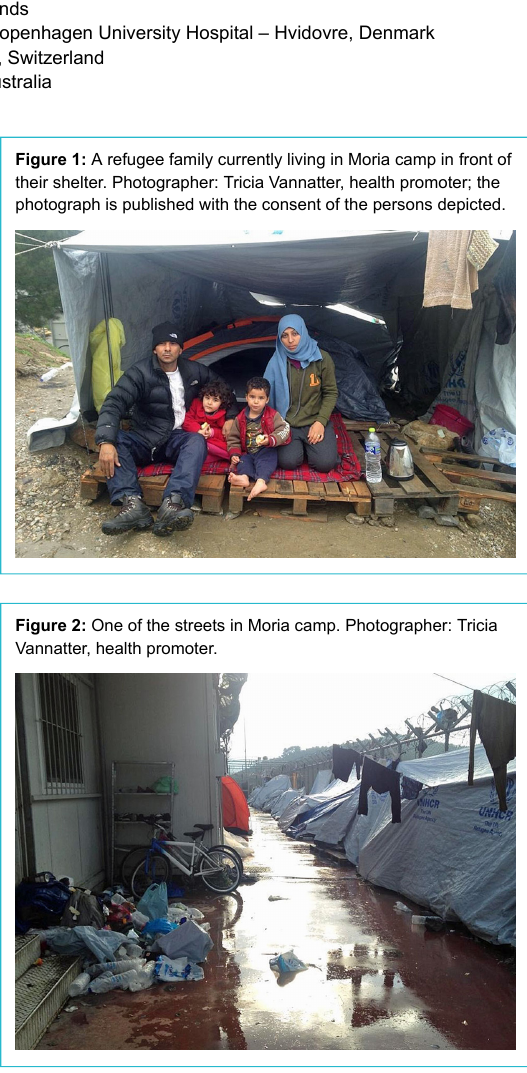
fore spacing out individuals. Experts in the field of